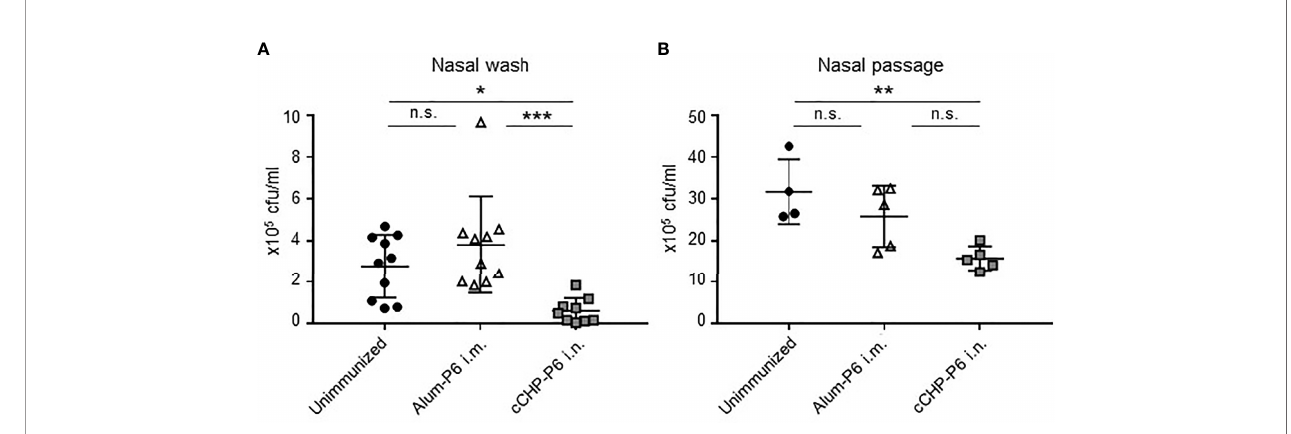
FIGURE 3 | cCHP-P6 nanogel nasal vaccine provides protective immunity against NTHi infection. (A, B) Bacterial clearance from the nasal cavity was determined by counting the numbers of live NTHi in nasal washes (A) or nasal passages (B) . The concentration of NTHi was expressed as colony-forming units (cfu) per milliliter of sample. Data are representative of three independent experiments, with n = 10 for Unimmunized or Alum-P6 and n = 9 for cCHP-P6 (A) and n = 4 for Unimmunized and n = 5 in Alum-P6 or cCHP-P6 (B) . * P < 0.05; ** P < 0.01; *** P < 0.005; n.s., not signi fi